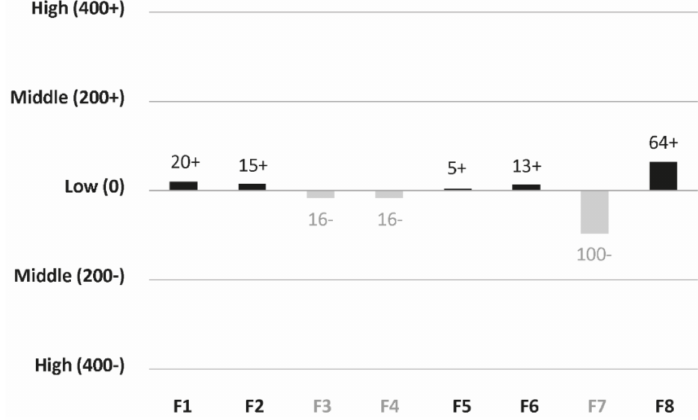
Figure 5. Results of the multiple-criteria decision analysis calculations: influence of the external factors on the goals of the most relevant market players (external factors characterized by a positive influence are over the low line and external factors characterized by a negative influence are under the low line) (F1: Renewable energy production; F2: Fossil fuels’ price; F3: Extreme weather events; F4: Social unacceptance of higher electricity prices due to incentives/subsidies; F5: Market concentration; F6: E-mobility; F7: Market liberalization; F8: EU economy